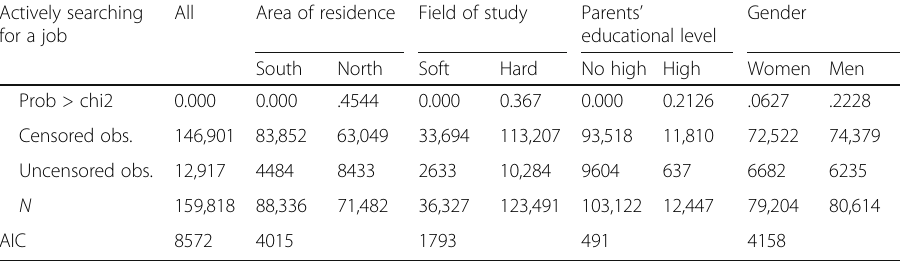
Table 4 Bivariate probit model for the probability of being not NEET and looking for a job (Continued) Actively searching for a